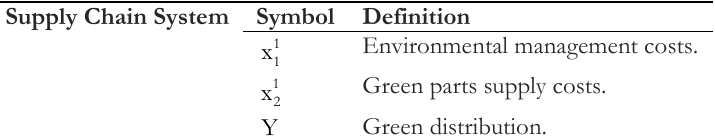
Table 6. Factors related to supply chain